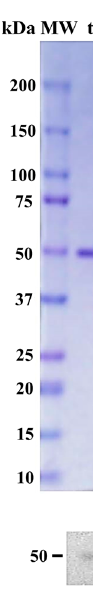
Figure 1. Purification and identification of t β 5 and t β 7 conglutin proteins. Two purified conglutin t β 5 and t β 7 proteins stained with Coomassie Brilliant Blue had a high level of purity (>95%) ( A ); Immunoblotting identified the same two purified β -conglutin proteins as the anti- β -conglutin antibody. MW, molecular weight standard (kDa) ( B ).